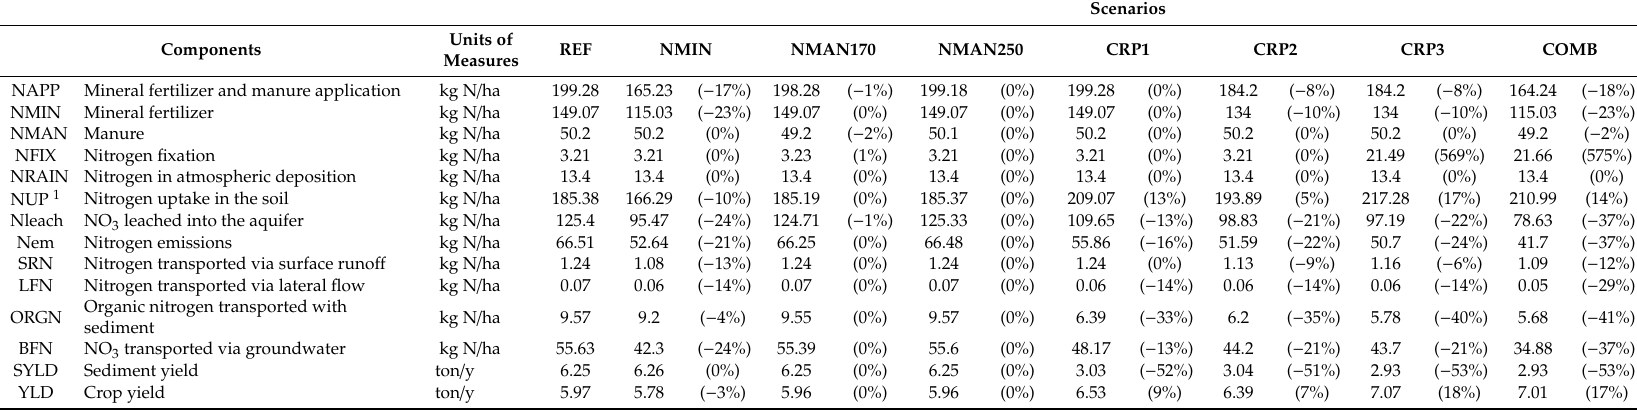
Table 9. Specific nutrient loads per scenarios in cropland HRUs (12,044 km 2 , 16% of the whole basin). In parenthesis the percentage of reduction (negative values) or increment (positive values) respect the baseline